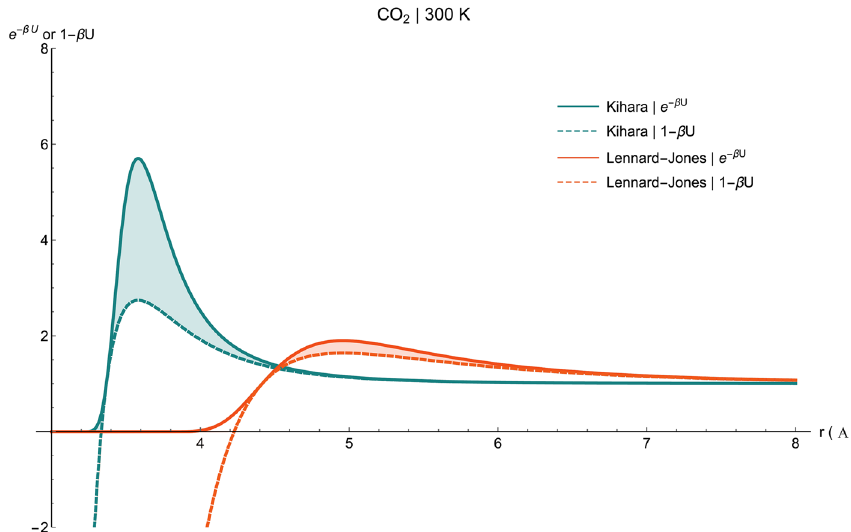
Figure 3. Comparison of the approximation terms between the Kihara and L-J